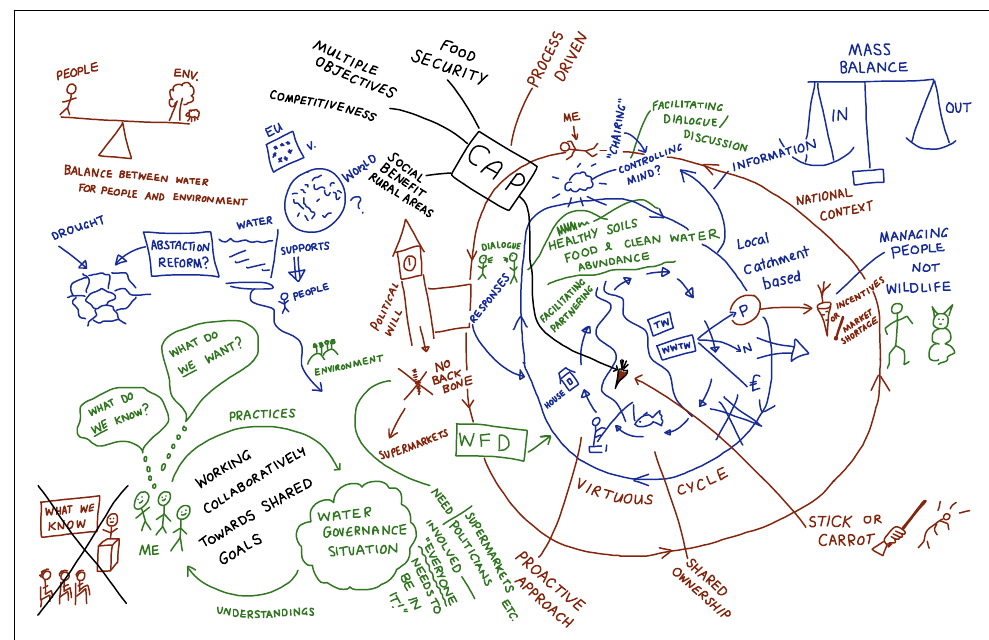
Figure 3. A rich picture of an ‘ideal’ water governance situation in England drawn by a group of workshop participants (redrawn from the version created at the workshop; see also Figure S3) [29]. From the rich pictures, the participants identified 15 themes (4–6 per group): Group